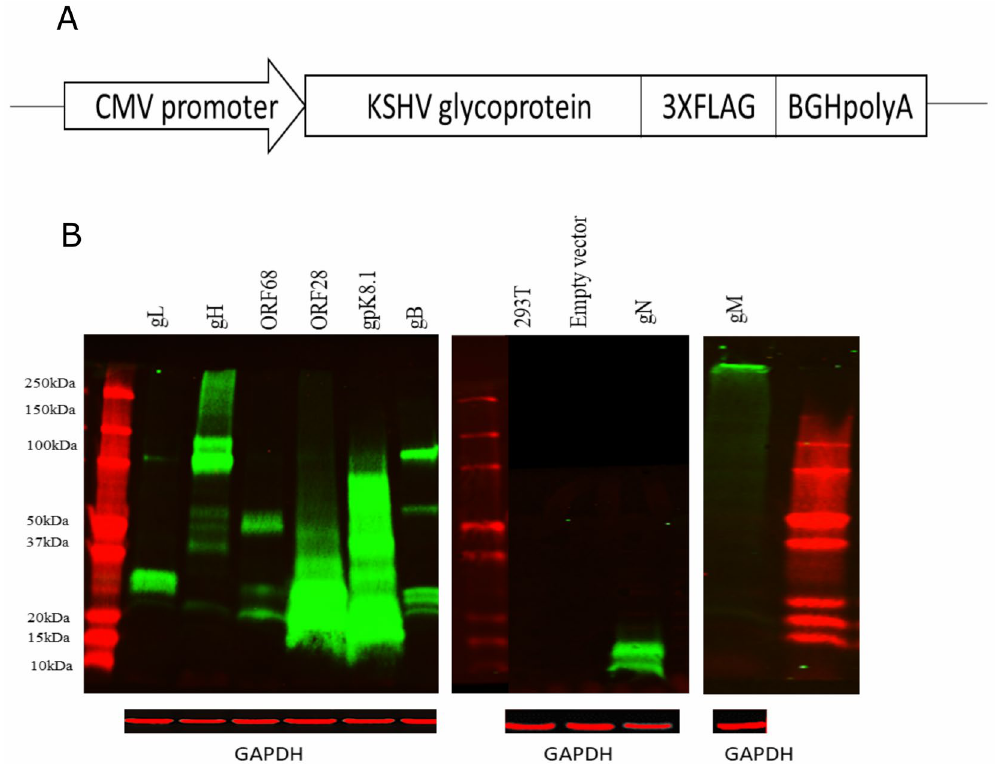
Figure 1. Kaposi’s sarcoma-associated herpesvirus (KSHV) envelope glycoprotein constructs and their expression in 293T cells by immunoblot. ( A ) Schematic representation of pcDNA3.1 mammalian expression vector encoding KSHV glycoproteins fused with 3xFLAG at the C-terminus of each glycoprotein (not drawn to scale). ( B ) KSHV glycoproteins expression was demonstrated in the whole-cell lyses of transfected 293T cells by immunoblot against the 3xFLAG